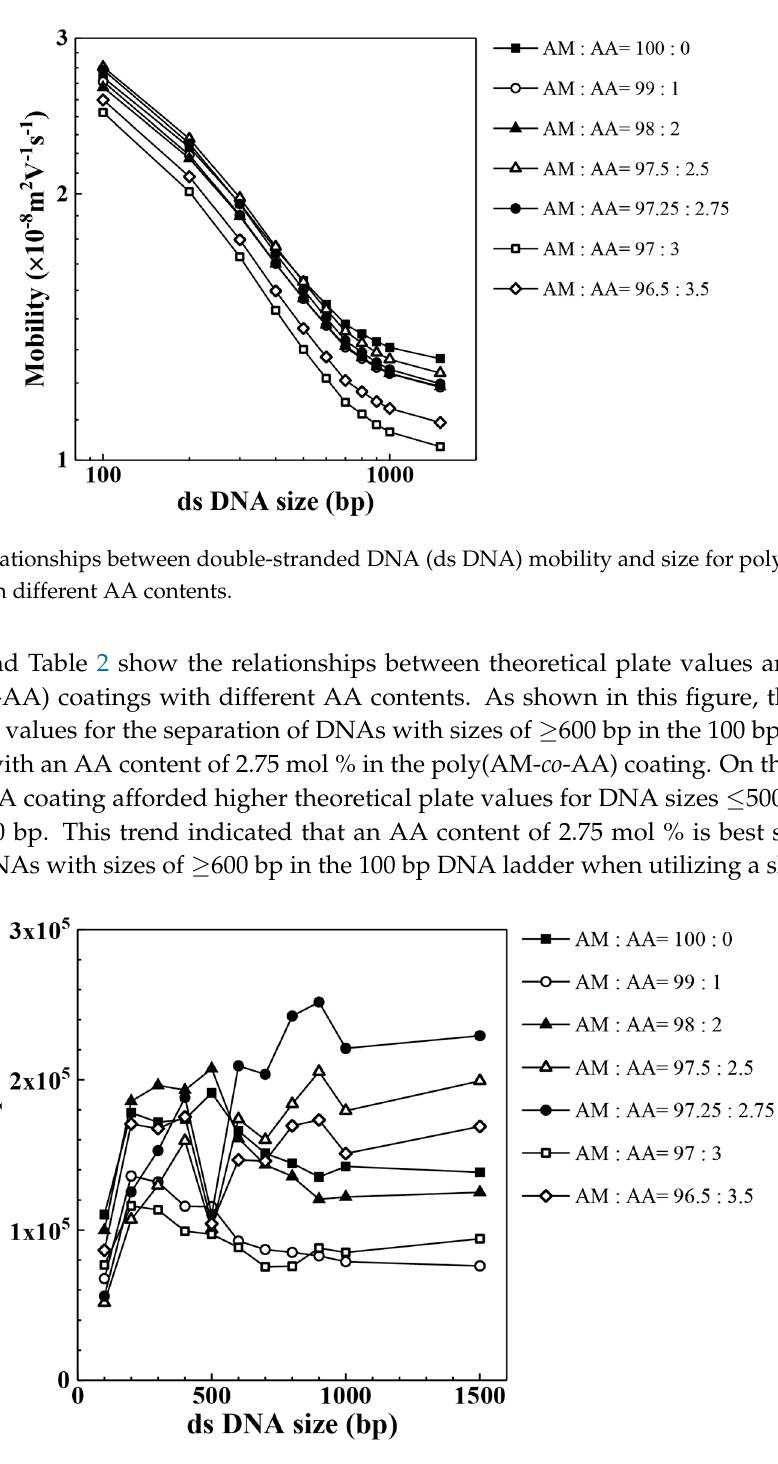
Figure 7. Relationship between theoretical plate values and the size of ds DNA for poly(AM- co -AA) coatings with different AA contents.